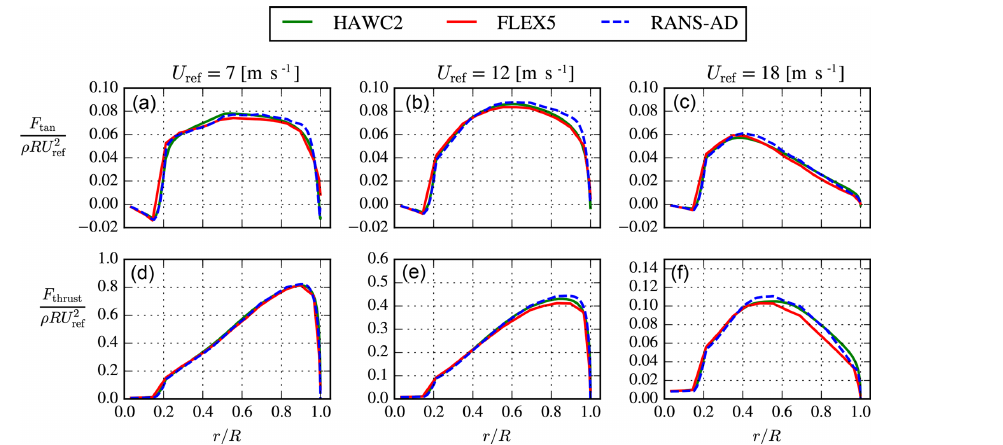
Figure 9. Comparison of simulated tangential (a–c) and thrust (d–f) force distribution of a single V29 rotor using HAWC2, FLEX5 and EllipSys3D